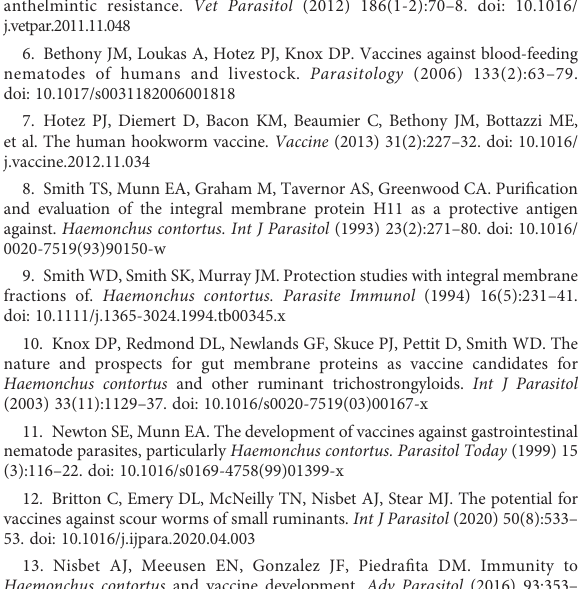
SUPPLEMENTARY TABLE 1 List of N-glycoproteins and N-glycosylation sites identi fi ed in native H11 from Haemonchus contortus.